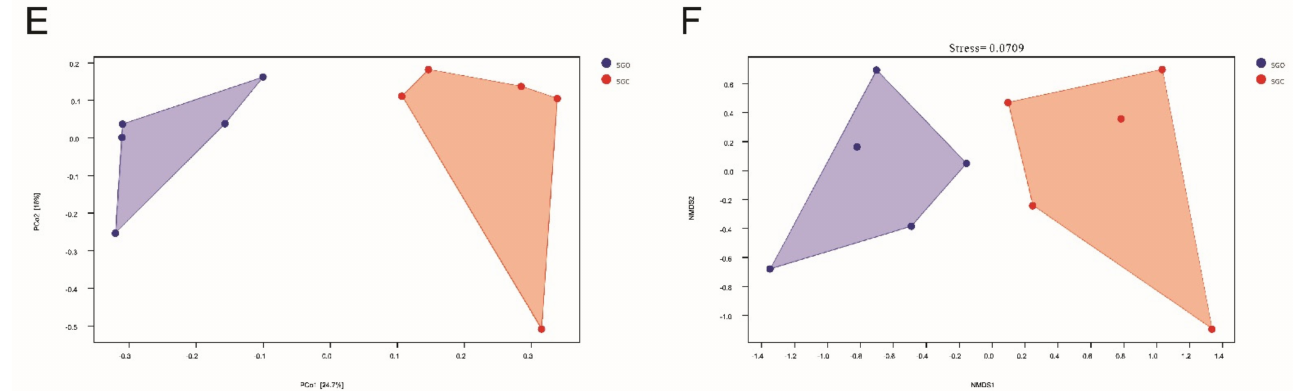
Figure 4. Principal coordinate analysis (PCoA) and nonmetric multidimensional scaling (NMDS) of microbial communities in shrimp farm samples with different oxygenator conditions. ( A ) PCoA of water. ( B ) NMDS of water. ( C ) PCoA of sediment. ( D ) NMDS of sediment. ( E ) PCoA of shrimp gut. ( F ) NMDS of shrimp gut.